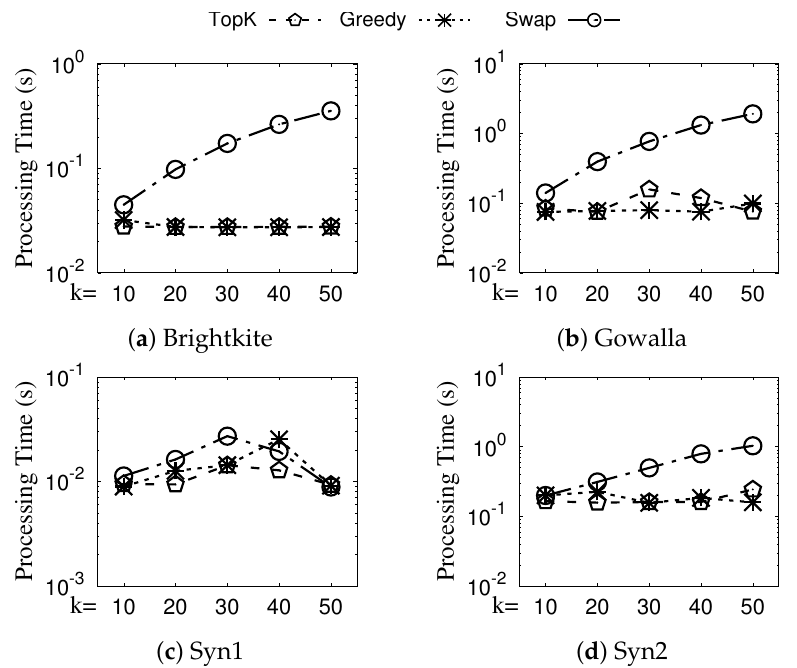
Figure 10. (Eval-VII) Efficiency evaluation (vary k